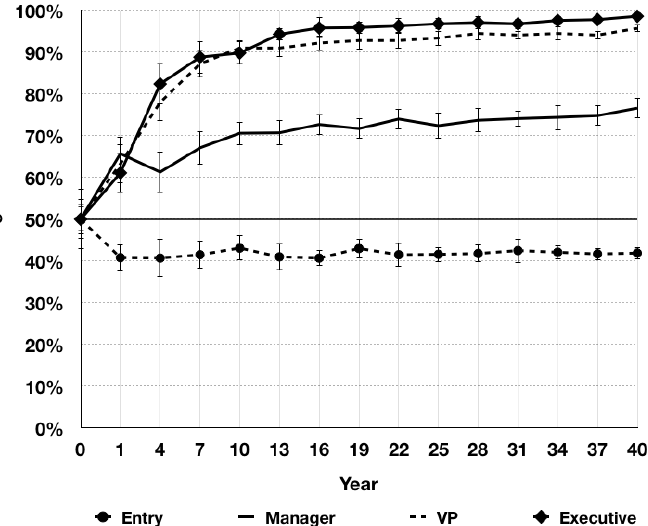
Figure 5. Fluctuations in gender balance across all four levels during a 40-year simulation when the promotion bias is 0.5.